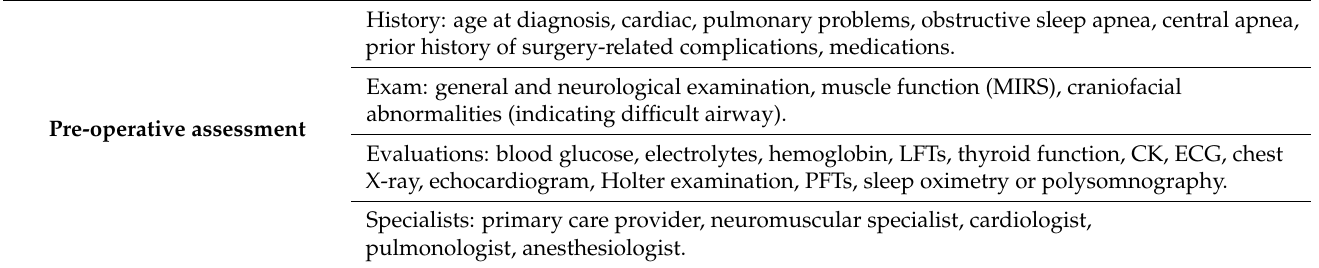
Table 5. Considerations regarding anesthesia in DM1 and